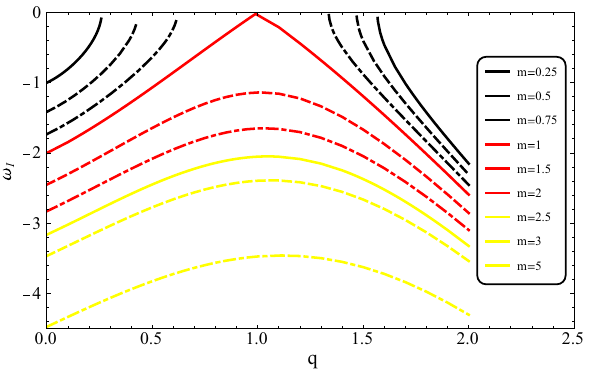
Fig. 7 The behavior of imaginary parts of QNMs ( ω I ) with respect to